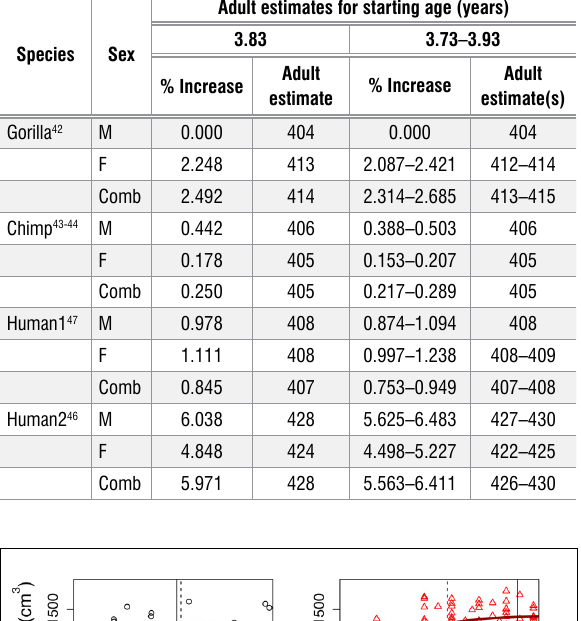
Adult cranial capacity estimates for Taung produced using narrowly defined starting ages